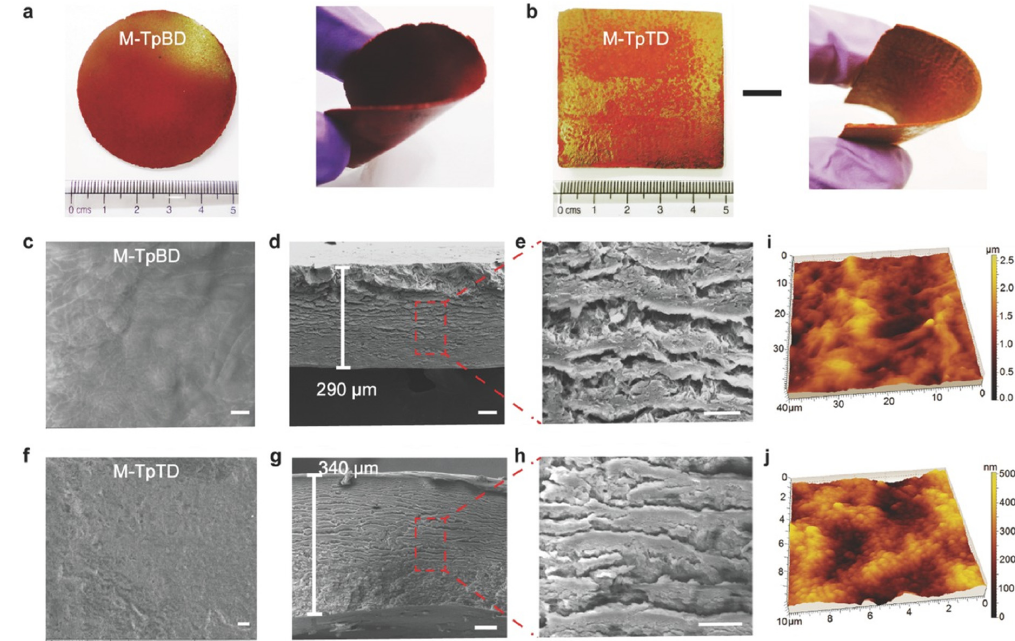
Figure 8. ( a , b ) Photographs of M-TpBD and M-TpTD demonstrating the membrane flexibility. ( c , f ) SEM images showing surface of M-TpBD and M-TpTD COMs, which also infer that the membrane surface is free from defects and cracks; ( d , g ) is the cross-section; ( e , h ) is the corresponding zoomed view of M-TpBD and M-TpTD respectively; ( i , j ) AFM images of M-TpBD and M-TpTD respectively showing the surface roughness recorded on the top of a silicon wafer (scale bars: ( c , f ) 5 μ m; ( d , g ) 50 μ m, and ( e , h ) zoomed view 10 μ m). Reprinted with permission from [79], Copyright (2016) John Wiley and Sons publications.